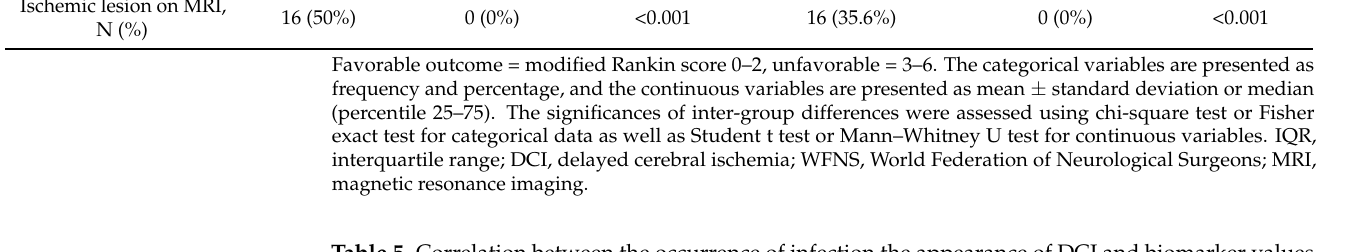
Table 5. Correlation between the occurrence of infection the appearance of DCI and biomarker values